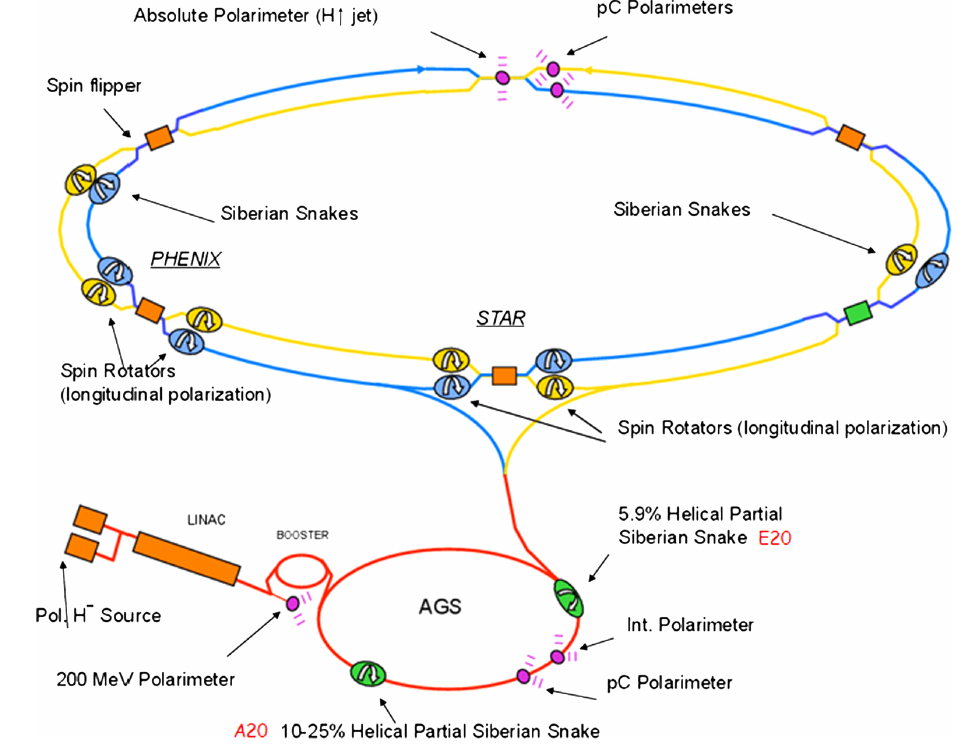
FIG. 1. Schematic diagram of the RHIC accelerator complex with the location of the A20 and E20 helices of the